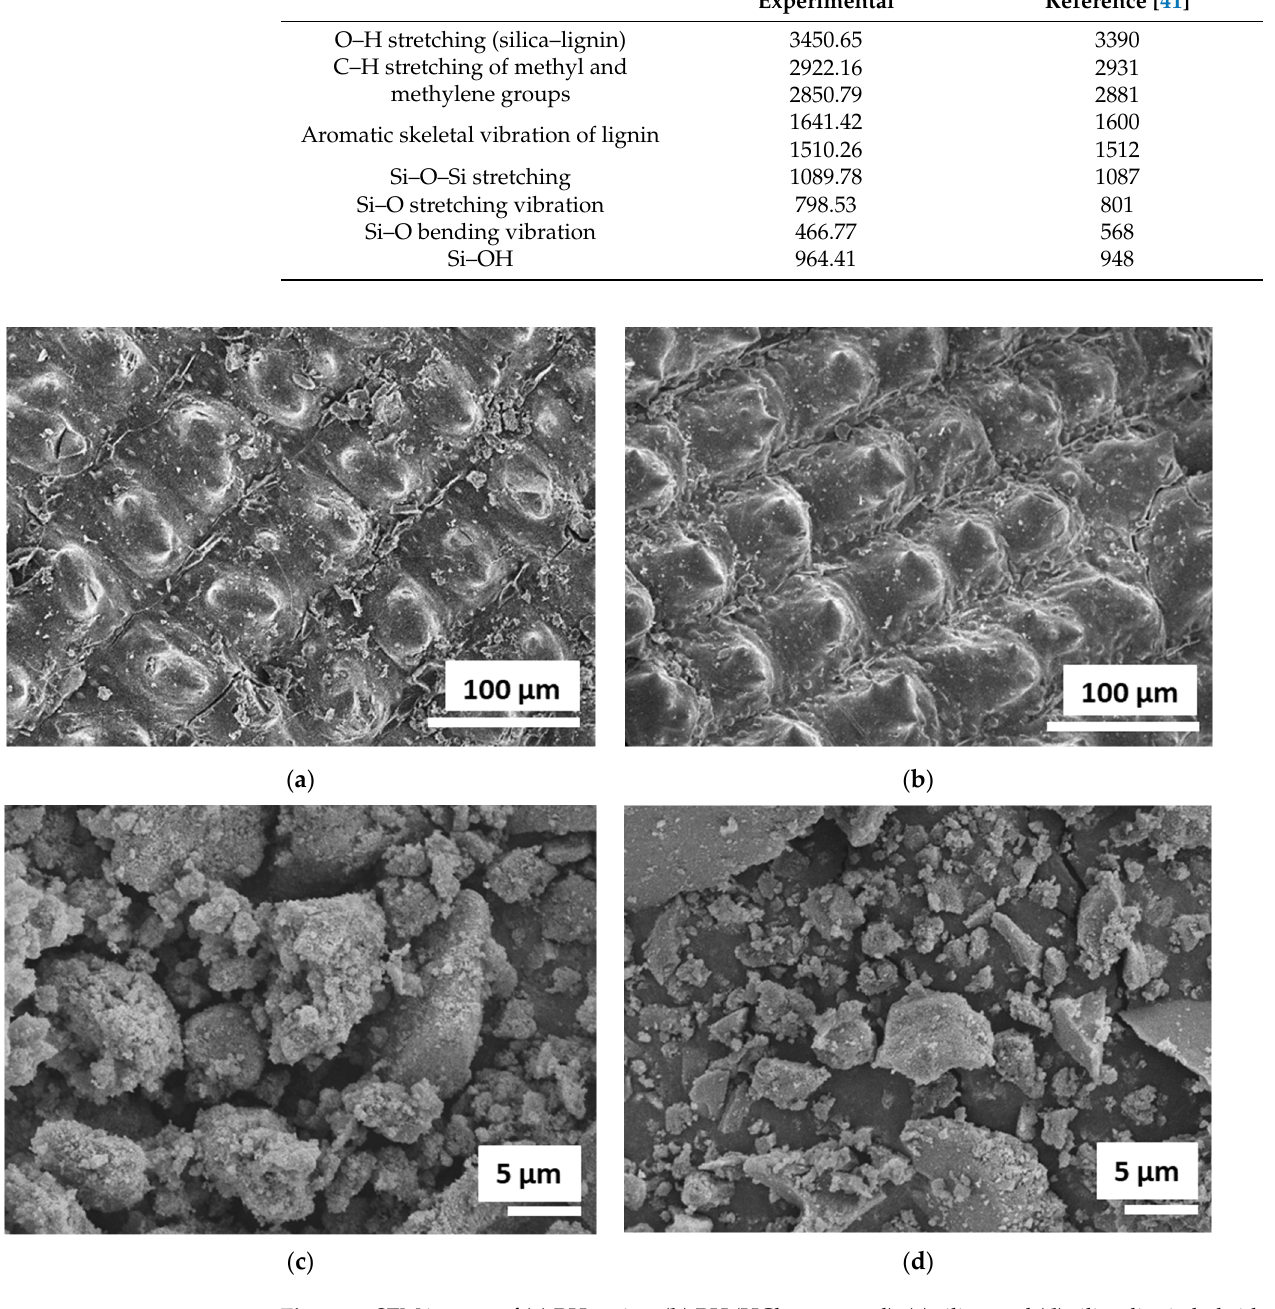
Figure 2. SEM images of ( a ) RH native; ( b ) RH (HCl-pretreated); ( c ) silica; and ( d ) silica–lignin hybrid.